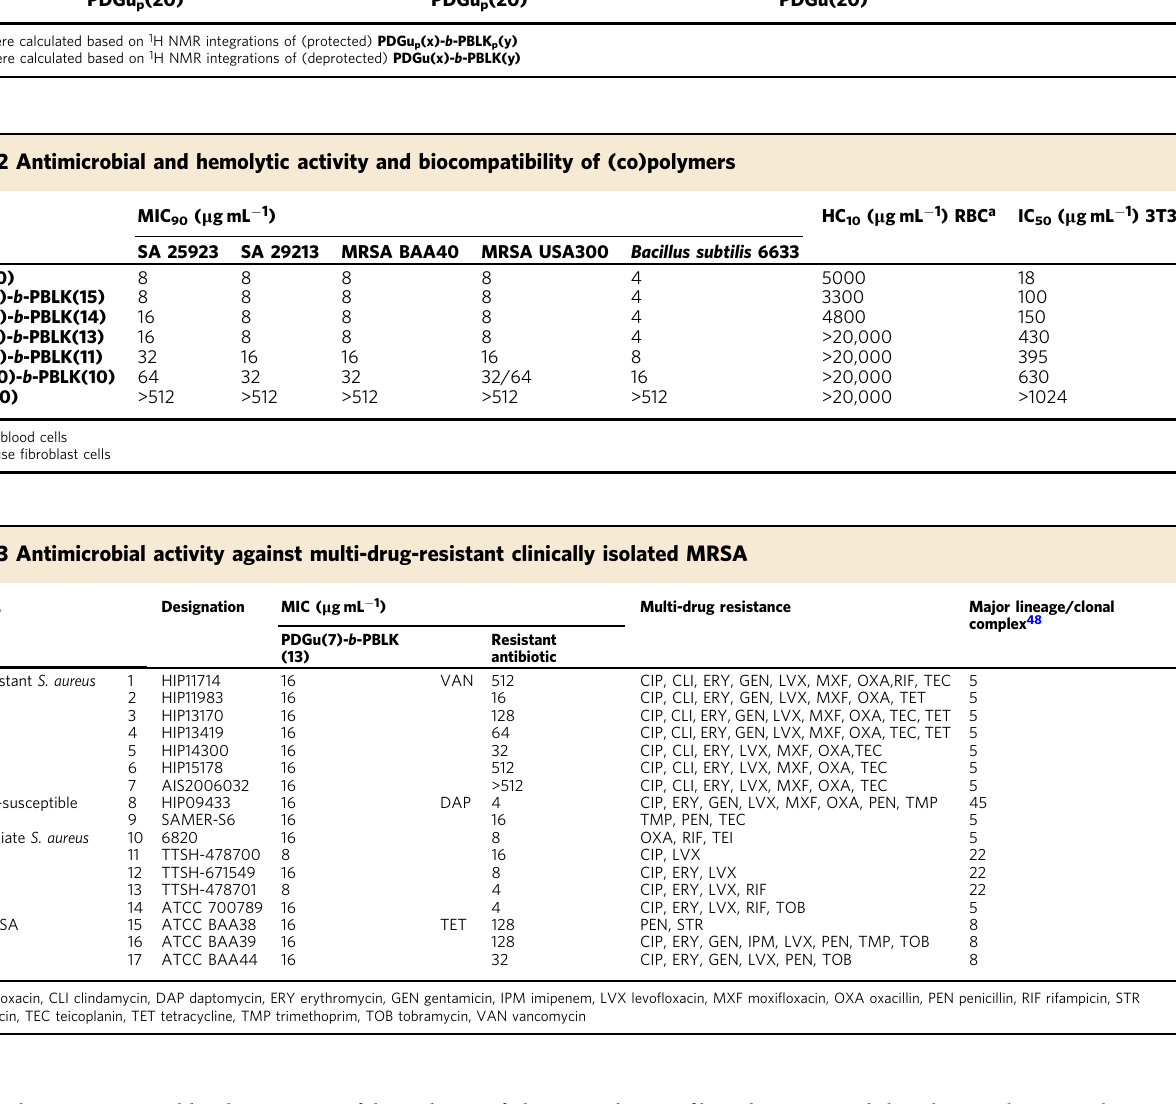
Table 2 Antimicrobial and hemolytic activity and biocompatibility of (co)polymers Sample